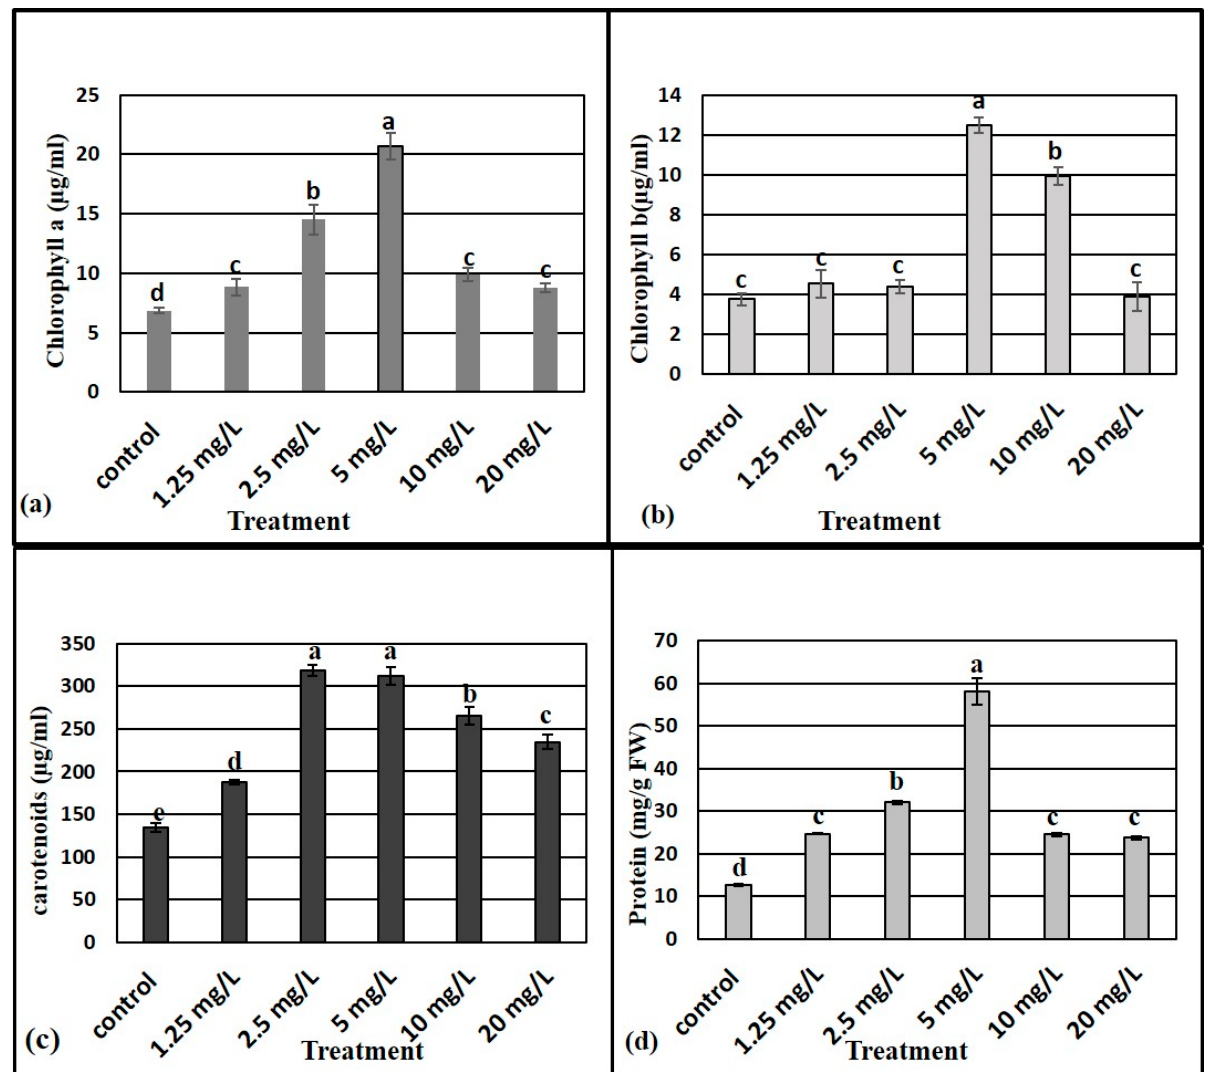
Figure 3. Effect of different concentrations of zinc oxide nanoparticles on the chlorophyll a ( a ), chlorophyll b ( b ), carotenoids ( c ) and protein ( d ) content of Maerua oblongifolia . Means ± SD for each concentration followed by the same letters are not significantly different according to one-way analysis of variance ( p ≤ 0.05).